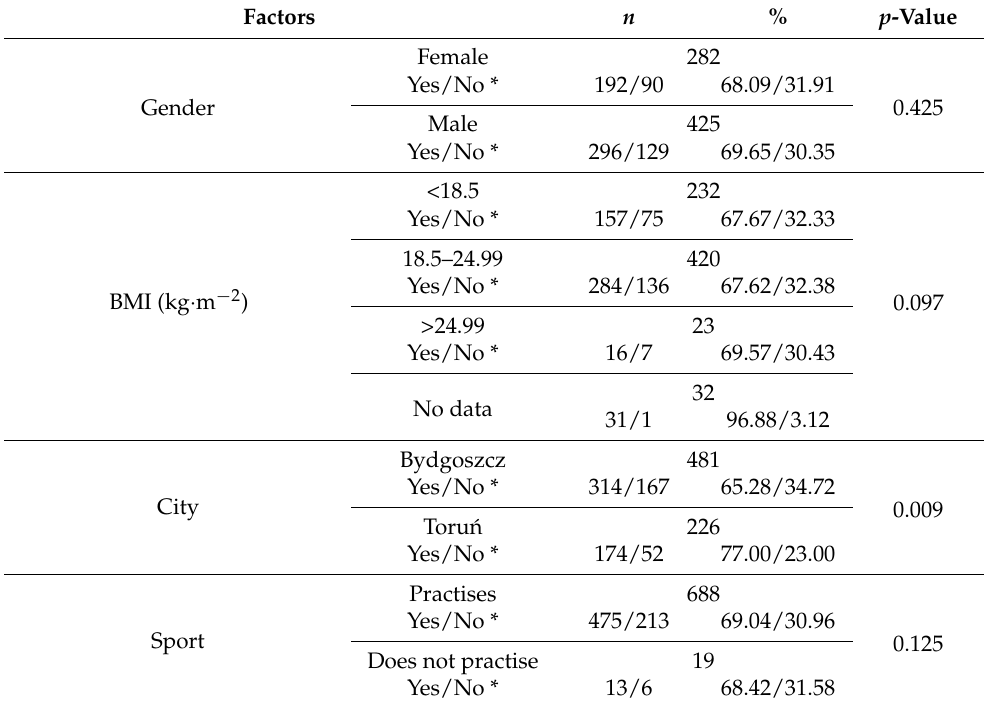
Table 3. Influence of various factors (sex, BMI, city, sports, frequency of practising sports) on EDs consumption by adolescent students attending junior secondary sports